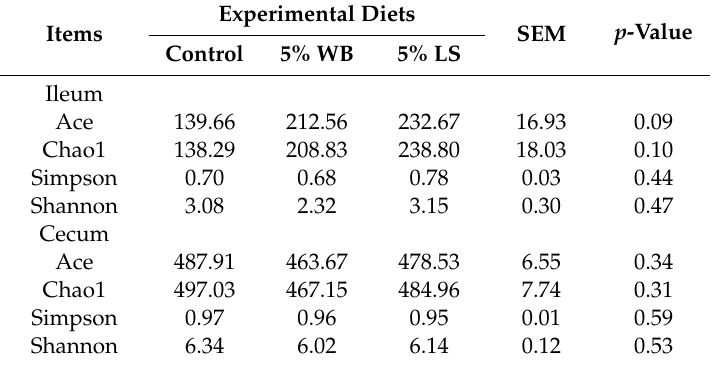
Table 2. Diversity indices of the ileal and cecal microbiota of 35-day-old broilers 1 .